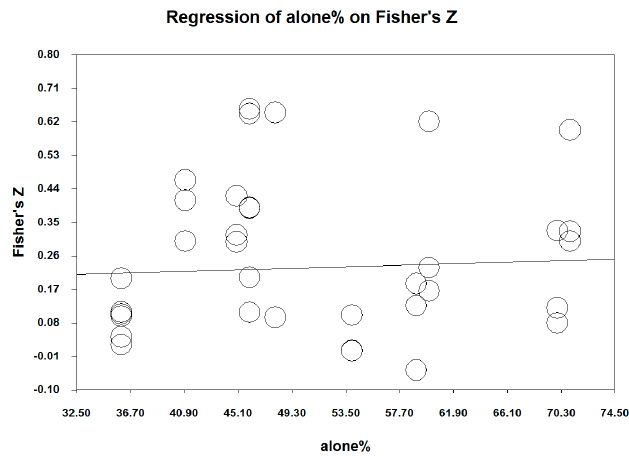
Figure 5. Fisher’s Z by the “absence of spouse” ratio.